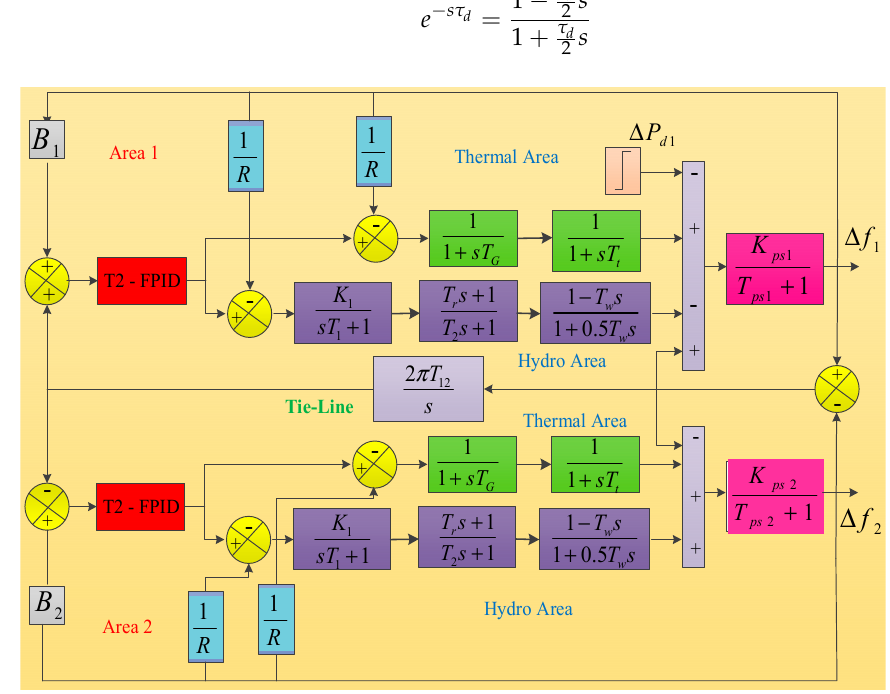
Figure 1. Dual-area conventional hydro-thermal plant (DAHT) (test system 1) [24].